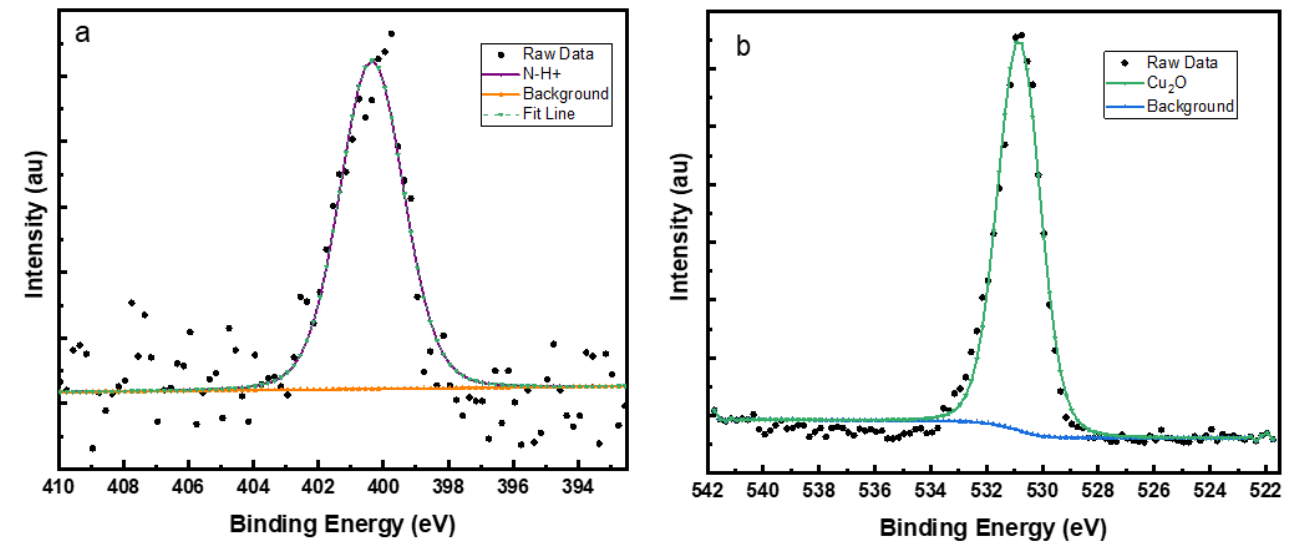
Figure 12. ( a ) N 1s and ( b ) O 1s XPS spectra of P2T treated brass sample.